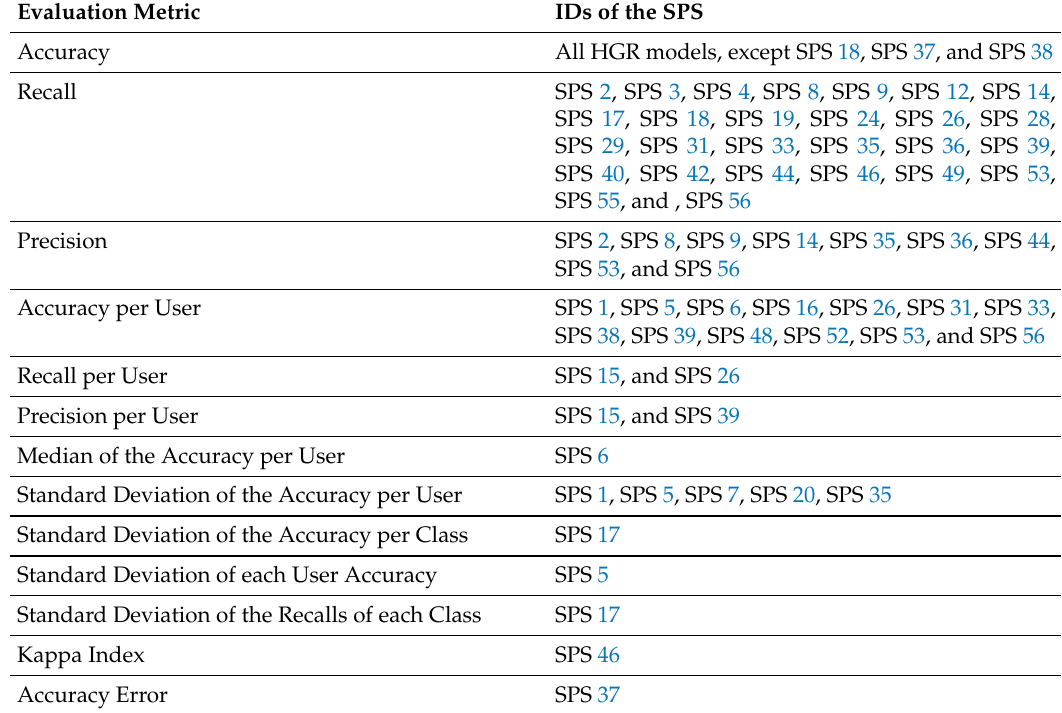
Table 12. The evaluation metrics for machine learning used by the 56 HGR